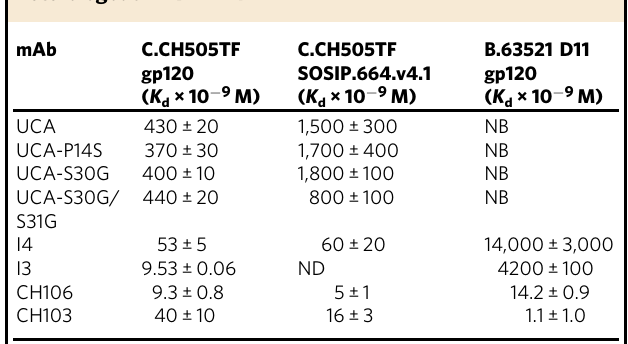
Table 2 Apparent af fi nity of the CH103 UCA mutant and lineage mAbs for transmitted founder (TF) and